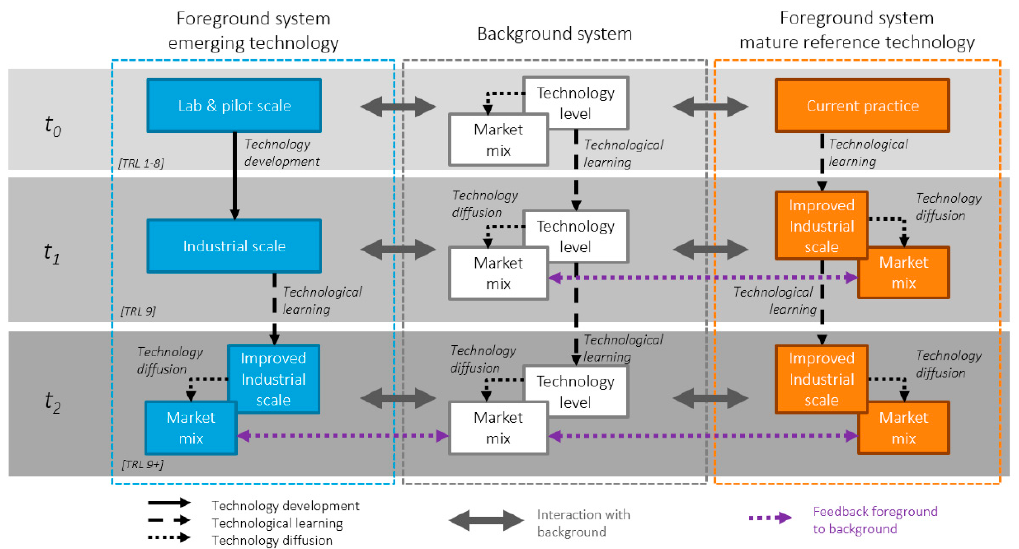
Figure 12. General framework for ex ante life cycle assessment. Blue signifies evolution of emerging technology under study, grey dashed box signifies the background system and orange signifies the foreground system of the mature technology. Reprinted, with permission, from [242].